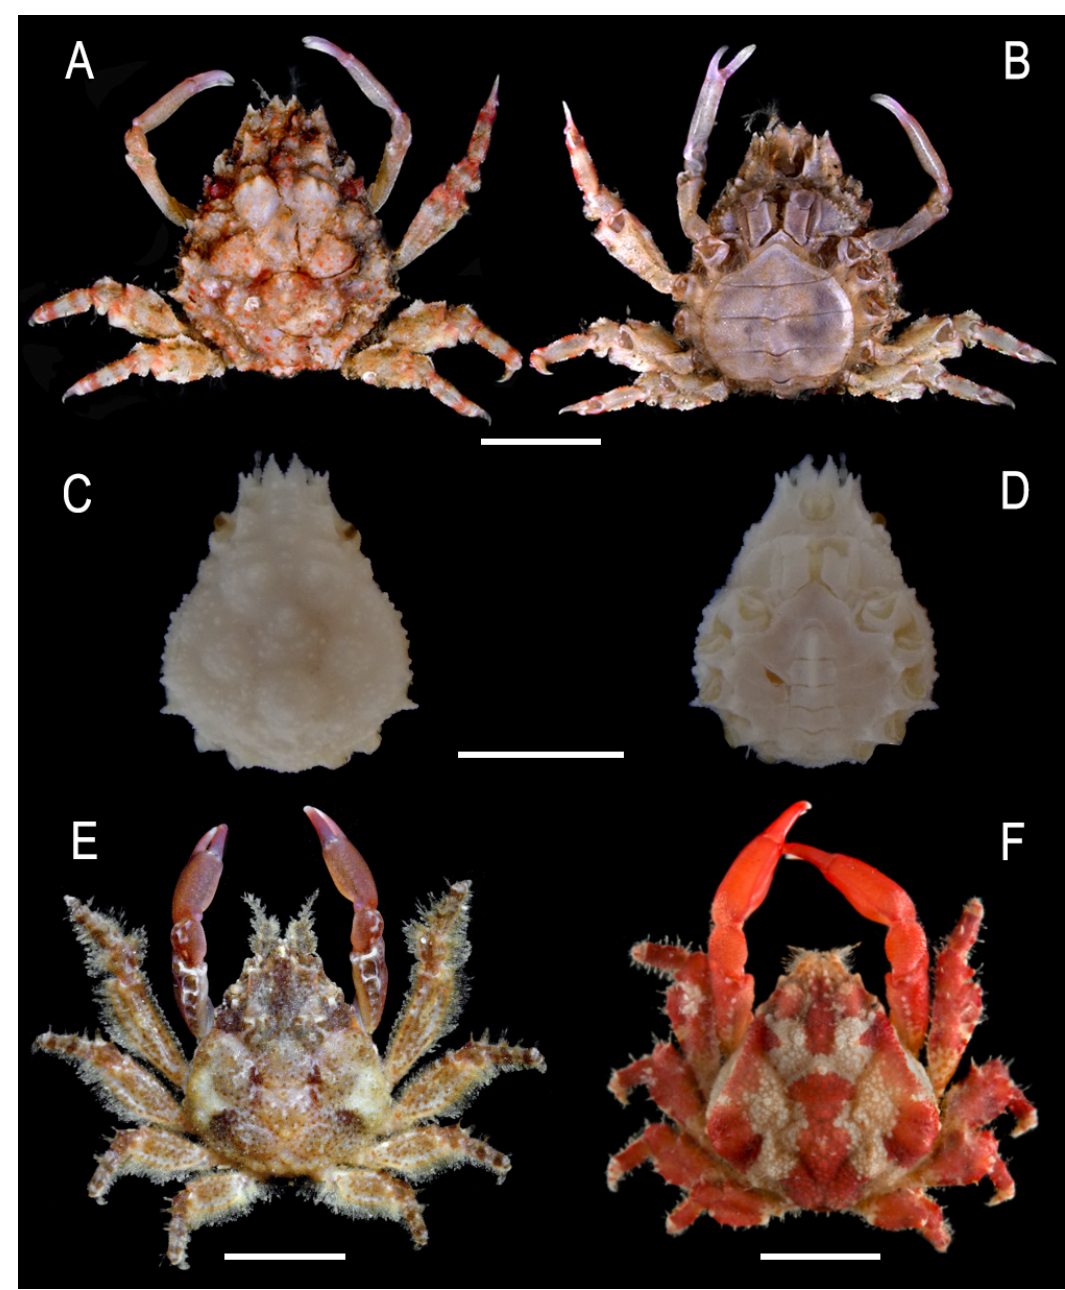
Figure 2. A – D Thoe aspera Rathbun, 1901. A , B , Female, CL 7.5 mm, CW 6.78 mm, Brazil (LSZ 185). C , D , Male lectotype, CL 9.9 mm, CW 7.84 mm, Puerto Rico (USNM 23773). A , C, Habitus. B , D , Ventral view. E , Thoe erosa Bell, 1836, habitus, male, CL 8.6 mm, Panama (eastern Pacific) (ULLZ 9738). F , Thoe puella Stimpson, 1860, habitus, male, CL 10 mm, CW 11 mm, Guadeloupe (MNHN IU 2013 4256). Credit of photos: E, D. Felder; F, J. Poupin. Scale bars: 0.5mm. distal spines. Palm of cheliped 3 times longer than